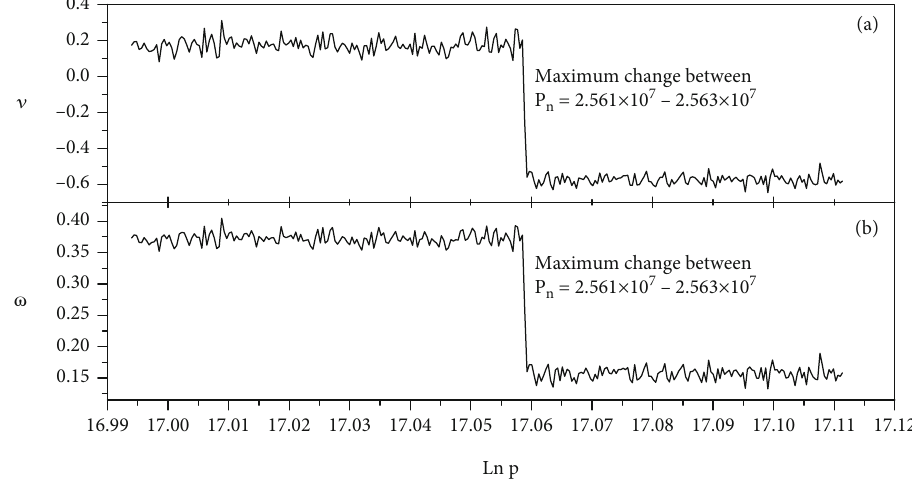
Figure 4: (a) The relation between the prime number of every 10 4 primes separately and the inverse χ 2 parameter ν from 24 million up to 27 million primes. (b) The relation between the prime number and Brody parameter ω for the same region and separation